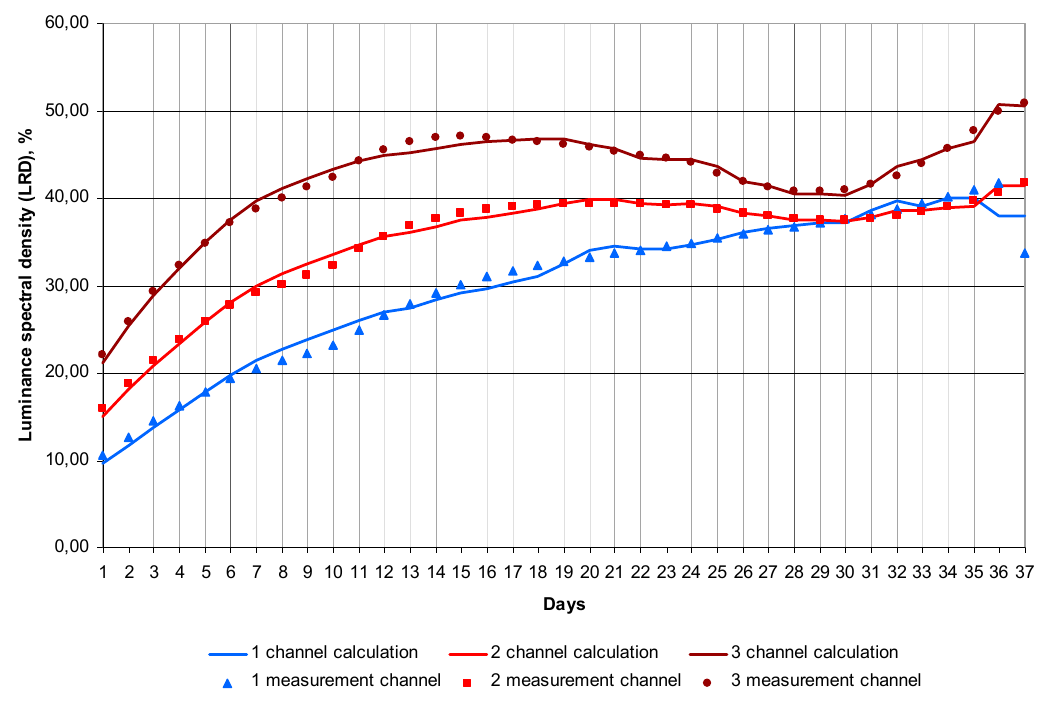
Figure 4. Dynamics of the reflection parameters of spring wheat sowing in the time interval from heading to grain ripening. 1 channel—green, 2 channel—red, 3 channel—near IR.